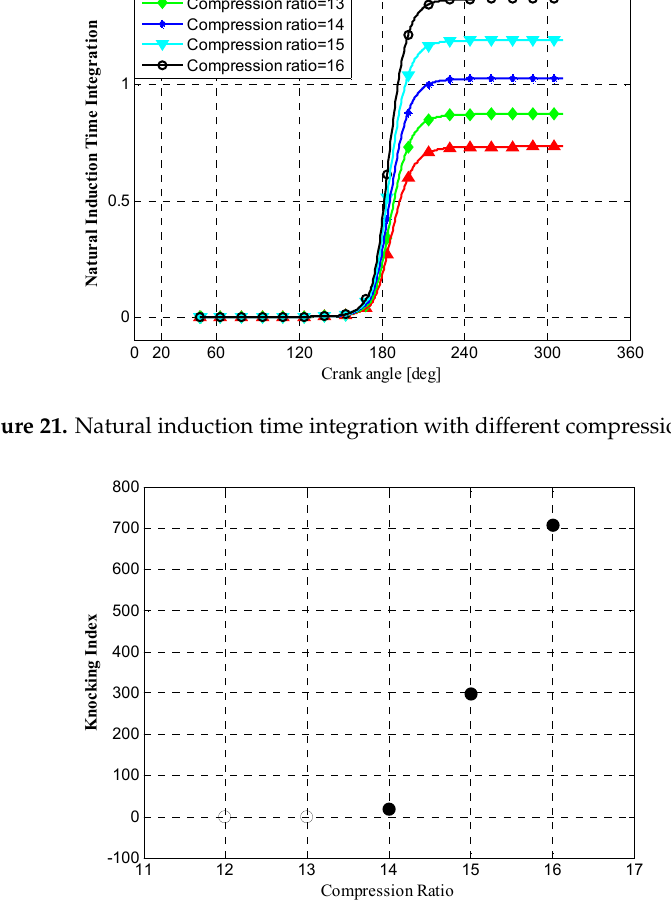
Figure 22. Knocking index with different compression ratios.